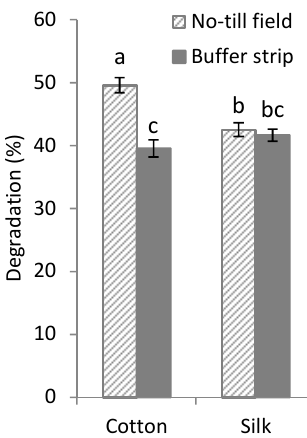
Figure 3. Degradation percentage of mean values of both treated and non-treated cotton and silk threads of Fertimetro observed in the NT field and vegetated BS. Pairs of data sharing the same letter are not significantly different ( p > 0,05). Bars report the standard error.